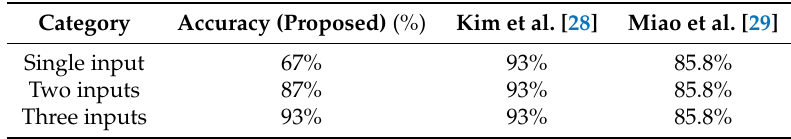
Table 3. Accuracy of detection and